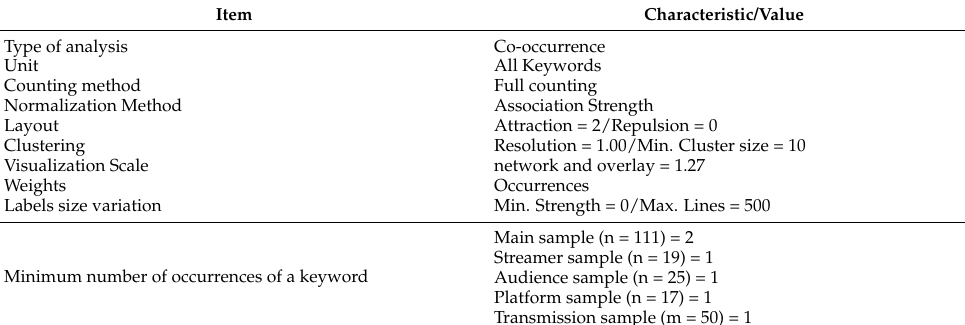
Table 1. VOSviewer